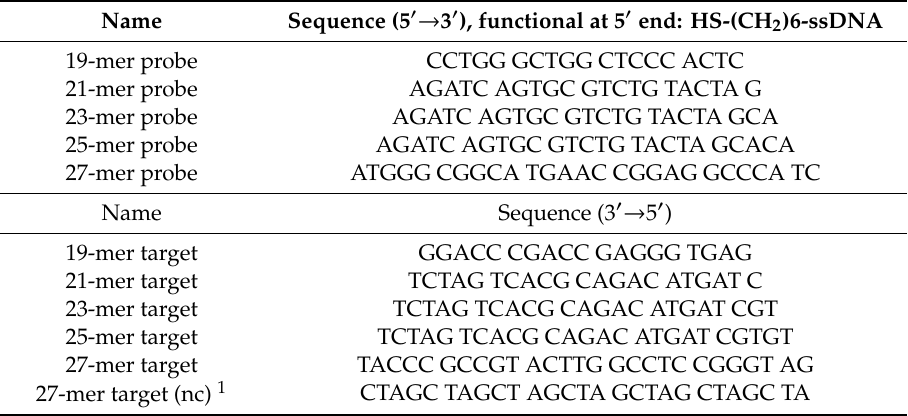
Table 1. Sequences of ssDNA probes and target ssDNAs used in this